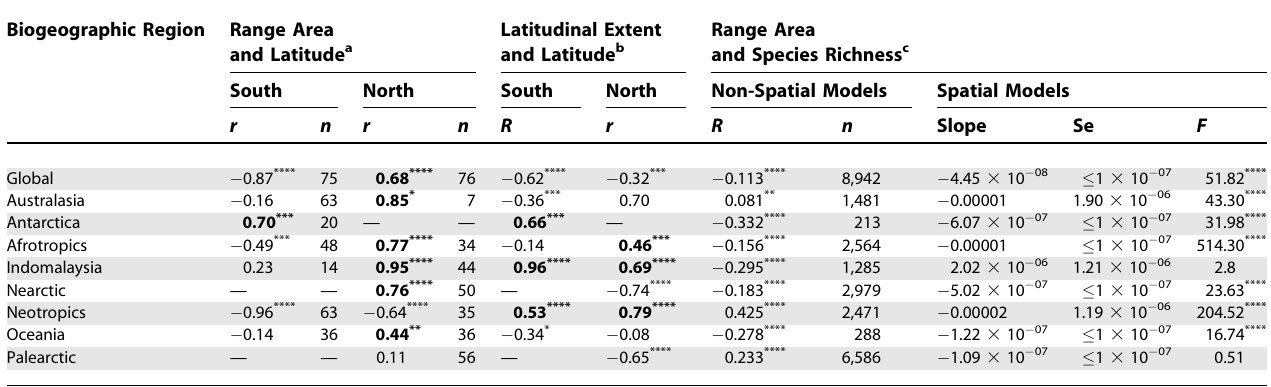
Table 1. Global and Within-Realm Patterns in Range Size Biogeographic Region Range Area and Latitude